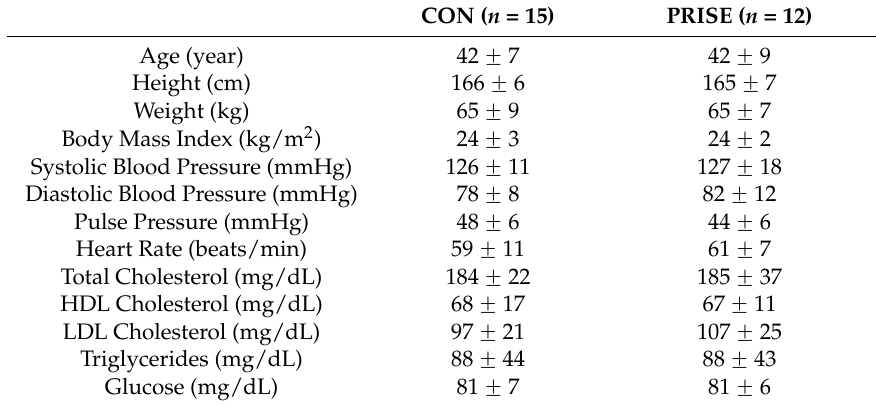
Table 1. Baseline subject characteristics ( N =